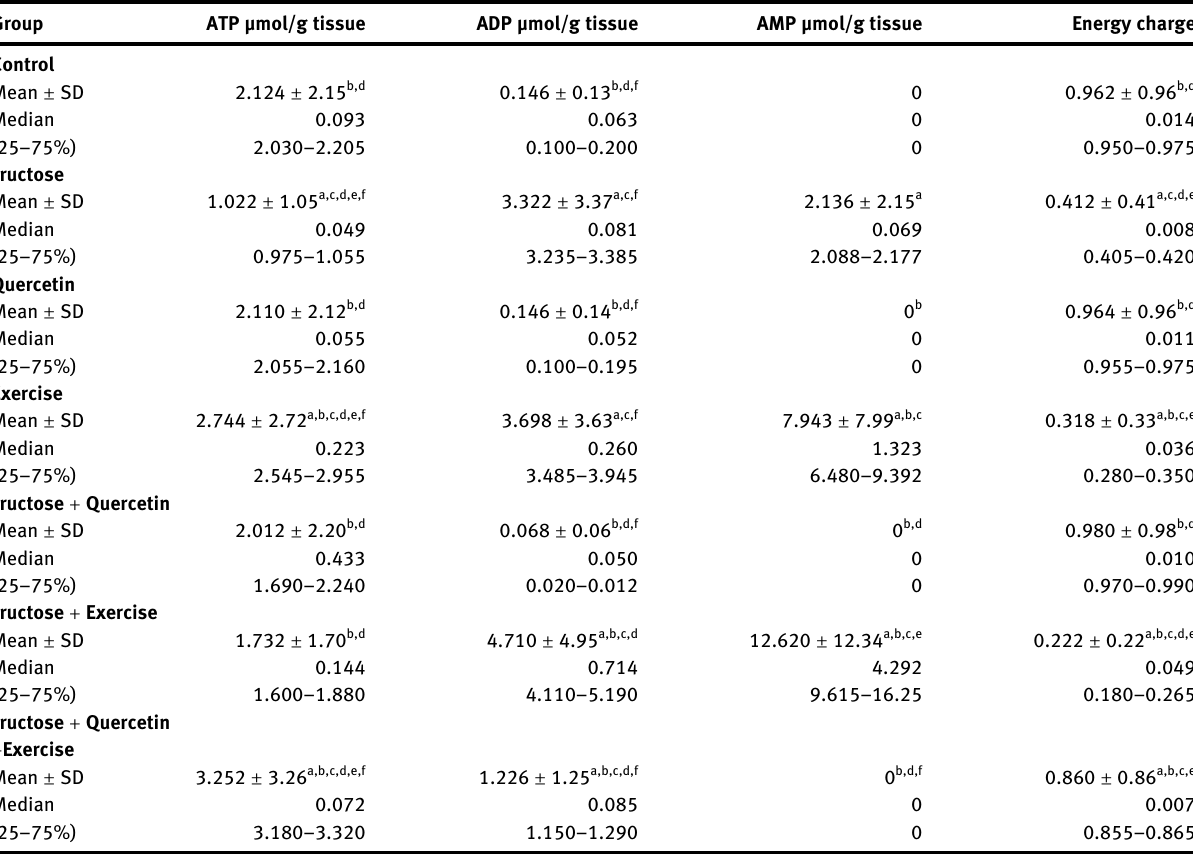
Table  : ATP, ADP levels and energy charge in muscle tissue. Group